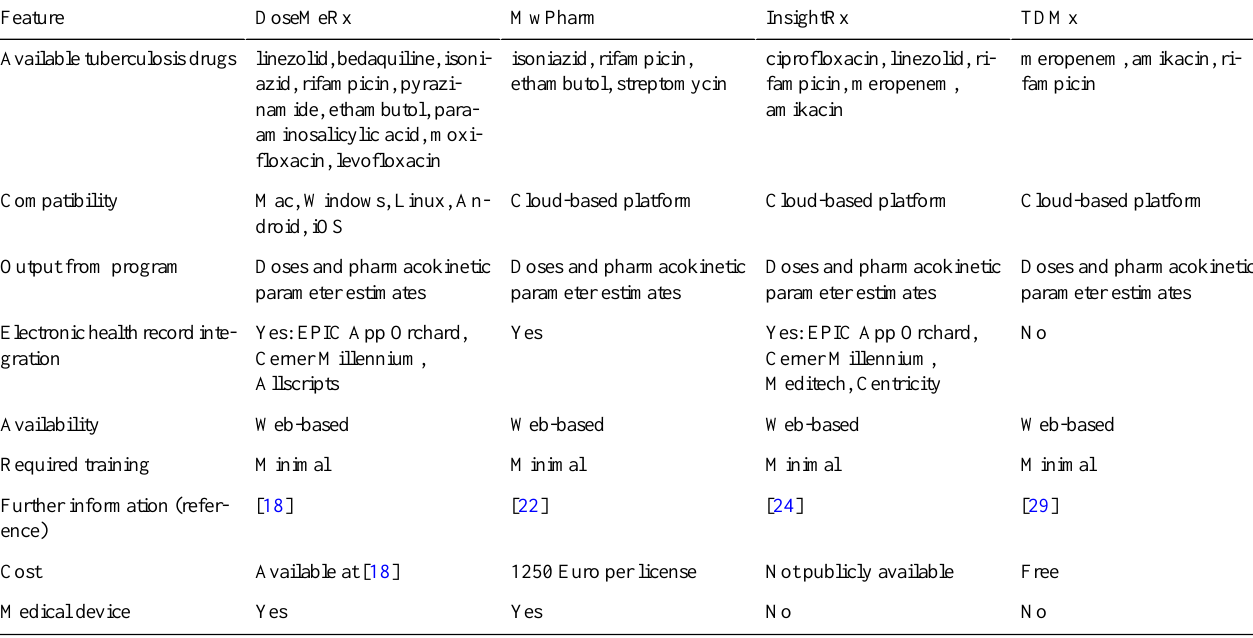
Table 2. Overview of mHealth apps for model-informed precision dosing of tuberculosis drugs.